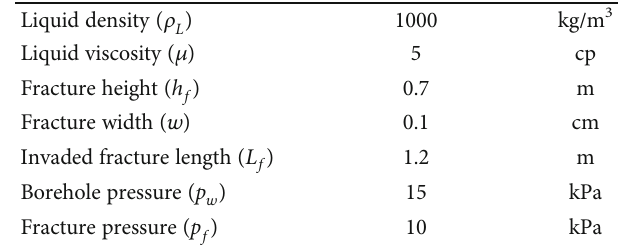
Table 2: Geometry and operating conditions in an experimental